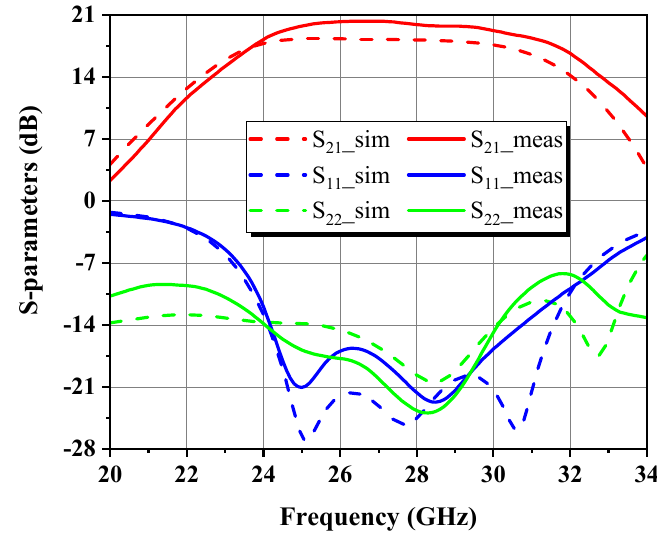
Figure 22. S-parameters of the proposed DA.